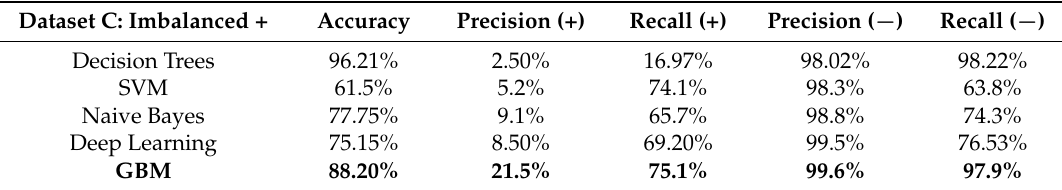
Table 8. Performance of GBM against other benchmarking methods for Dataset C positive imbalanced without any measures for the class imbalance problem.